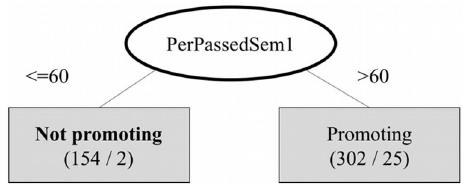
Figure 2. Decision tree corresponding to first semester